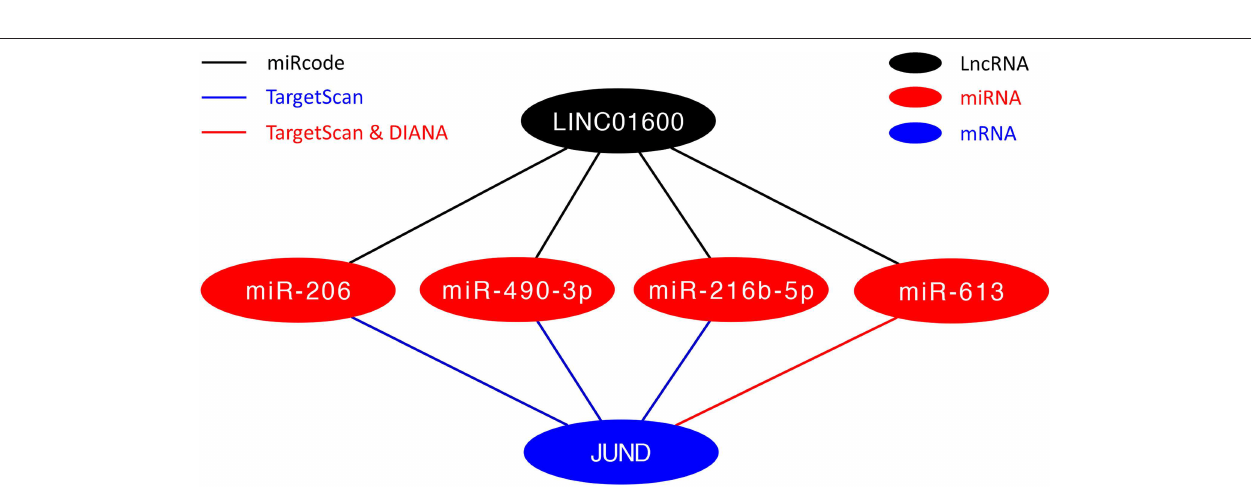
PCa cell lines only. The relationship between the expression of lncRNAs in PCa patients and radioresponse is still unclear.